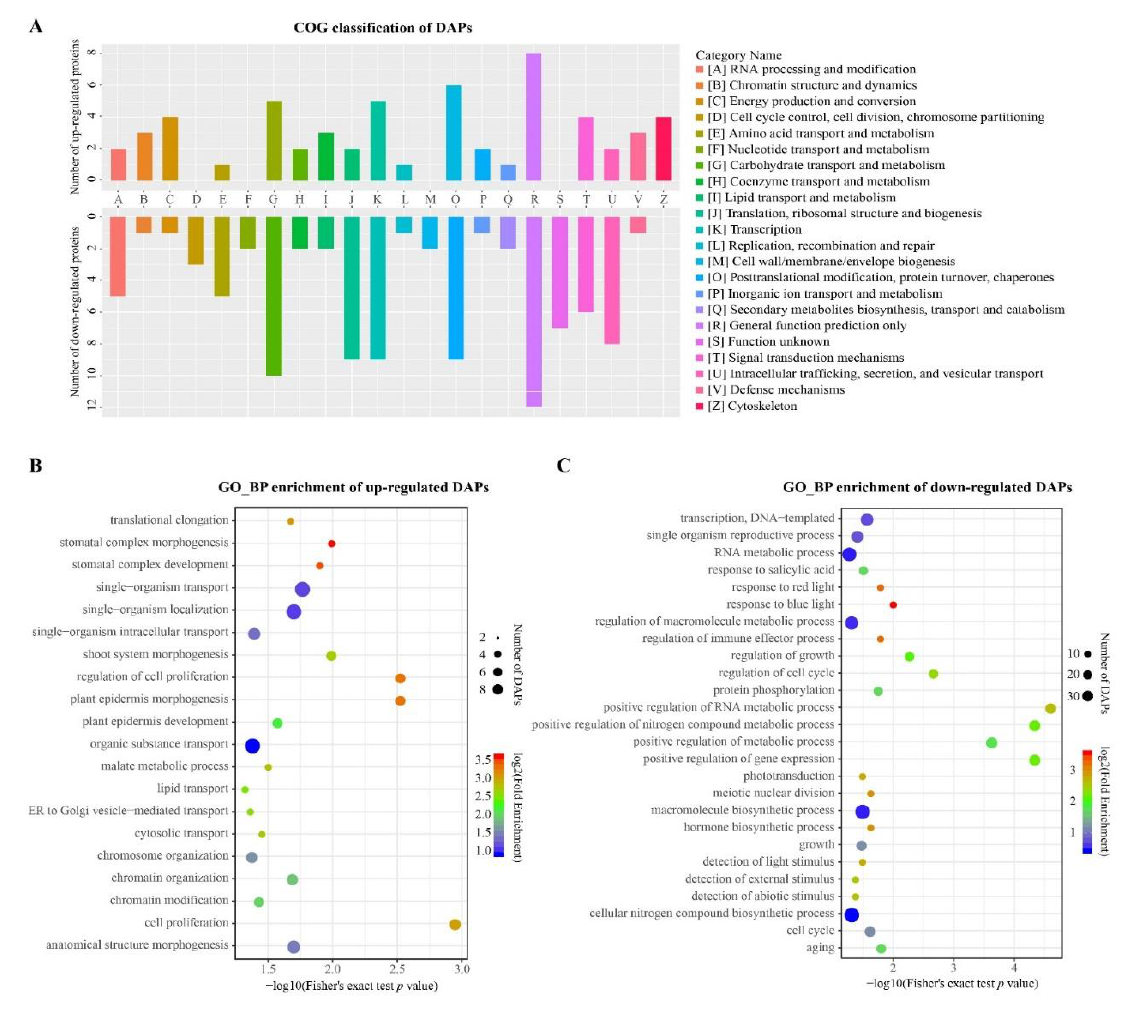
Figure 4. Functional annotation and enrichment analysis of the overlapped differentially accumulated proteins (DAPs): ( A ) clusters of orthologous genes (COG) classification of overlapped DAPs; ( B ) gene ontology_biological process (GO_BP) enrichment analysis of overlapped upregulated proteins (URPs); and ( C ) GO_BP enrichment analysis of overlapped downregulated proteins (DRPs).